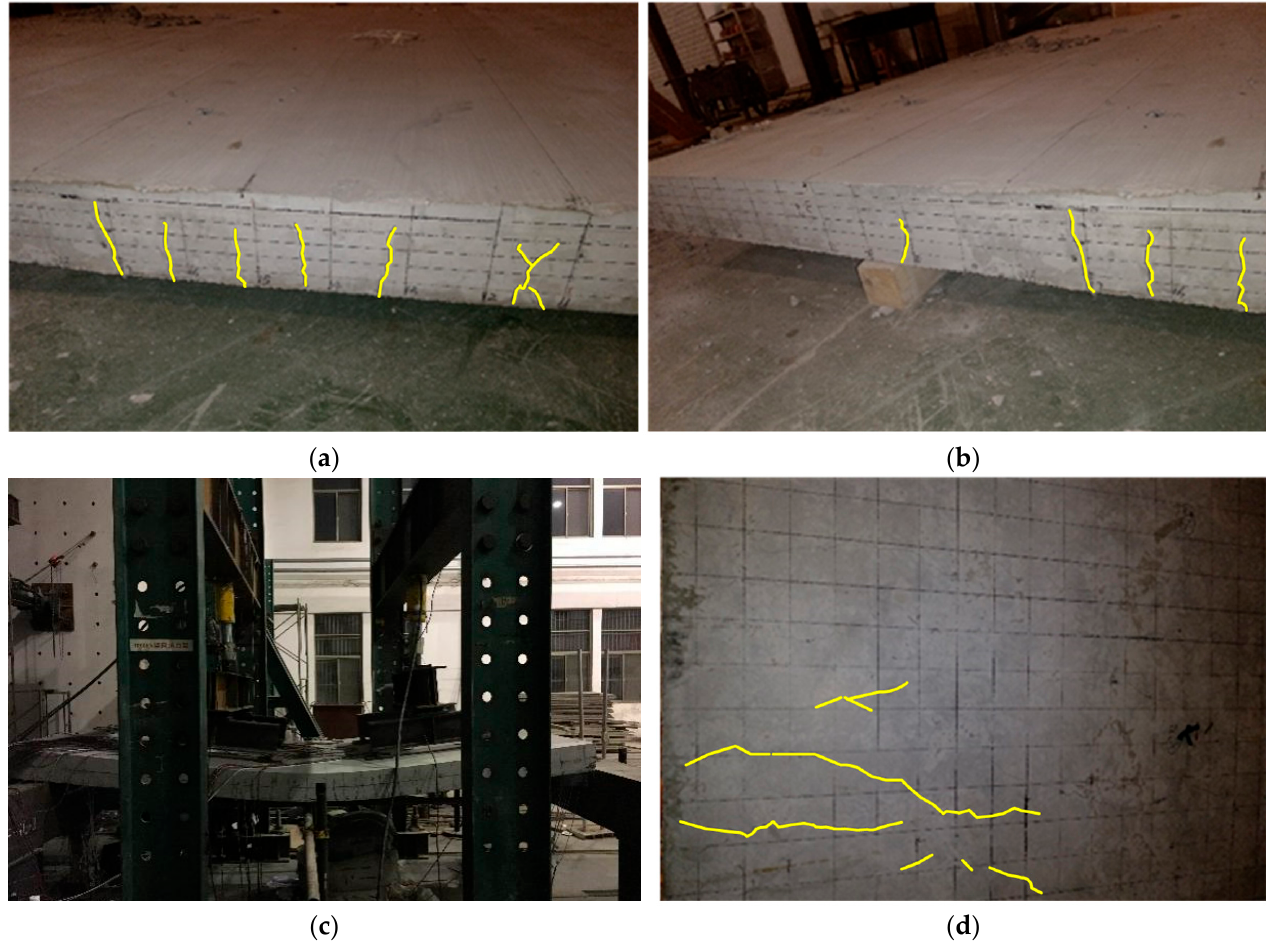
Figure 5. Typical failure modes of specimen WP. ( a ) First crack at the load of 35 kN. ( b ) Bending deformation at the end of the test. ( c ) Bending deformation in the test. ( d ) Cracks at the bottom of the wall.